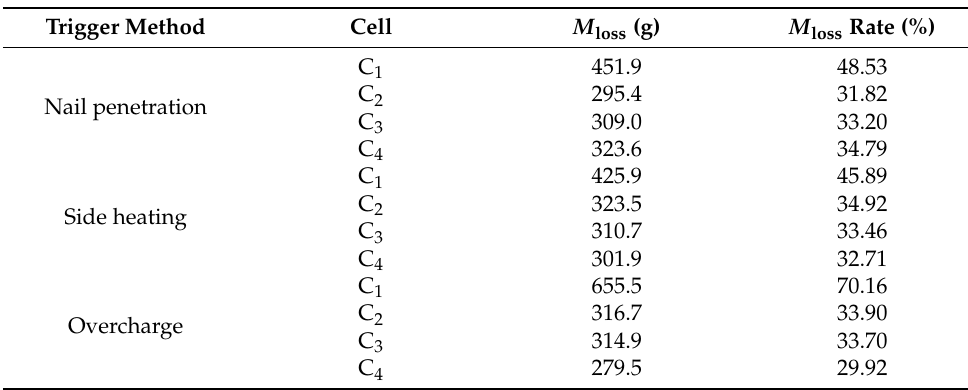
Table 4. Mass variation under different abuse